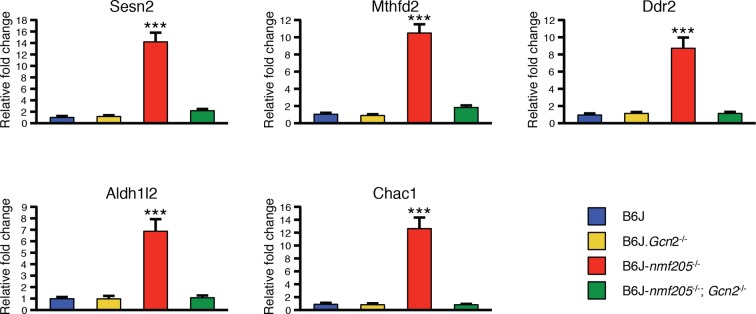
Quantitative RT-PCR showing the induction of ATF4 downstream genes is under the control of GCN2.RT-qPCR was performed on the cerebellar transcripts from B6J, B6J.Gcn2-/-, B6J-Gtpbp2nmf205-/- (B6J-nmf205-/-), and B6J- Gtpbp2nmf205-/- (B6J-nmf205-/-); Gcn2-/- 3-week-old mice for the top 5 ATF4 downstream genes that had the highest relative fold change in the 3-week-old B6J-Gtpbp2nmf205-/- cerebellum in the microarray study. Expression levels were normalized by Gapdh expression, and relative fold change was calculated relative to the expression of the B6J cerebellum. Three mice from each genotype were analyzed and error bars indicate SEMs. ***p<0.001.